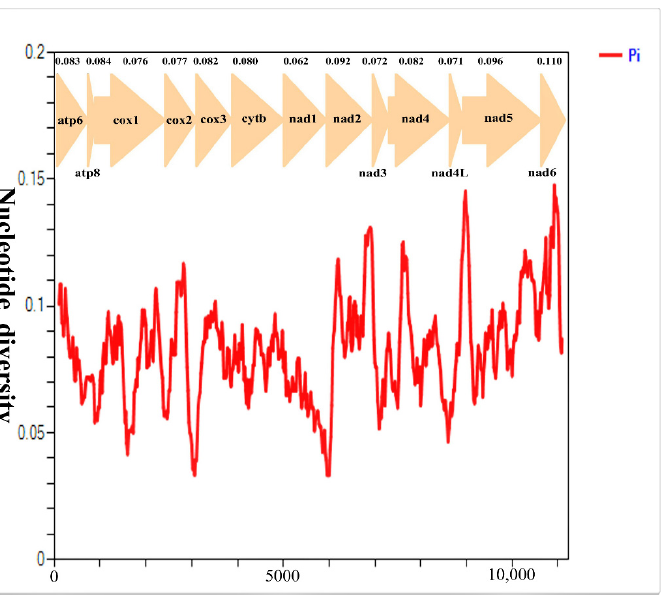
Figure 9. Nucleotide diversity on 13 PCGs in Macquartia . Sliding window analysis of 13 protein- coding genes among four Macquartia species. The red curve shows the value of Pi (nucleotide diversity). Pi value of each PCG is shown above the arrows.